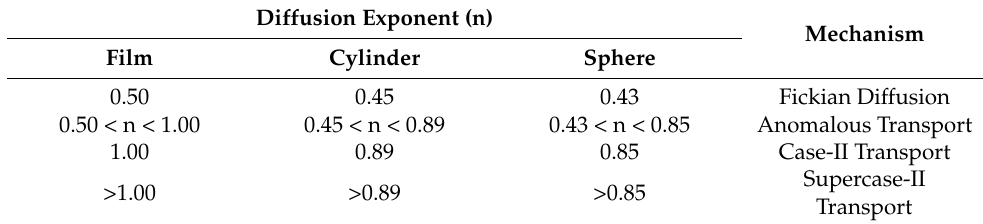
Table 9. Diffusion exponential and release mechanism of a